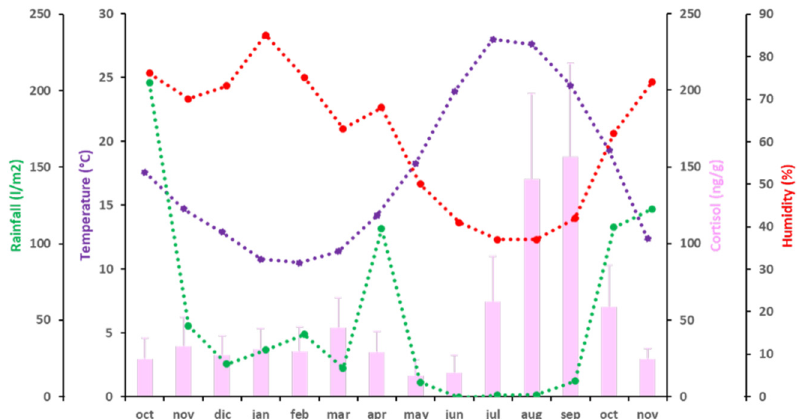
Figure 3. Independence of C (pink bars) and climatic variables [temperature (purple), rainfall (green) and humidity (red)] during the period of study. A discontinuous line represents independence of the